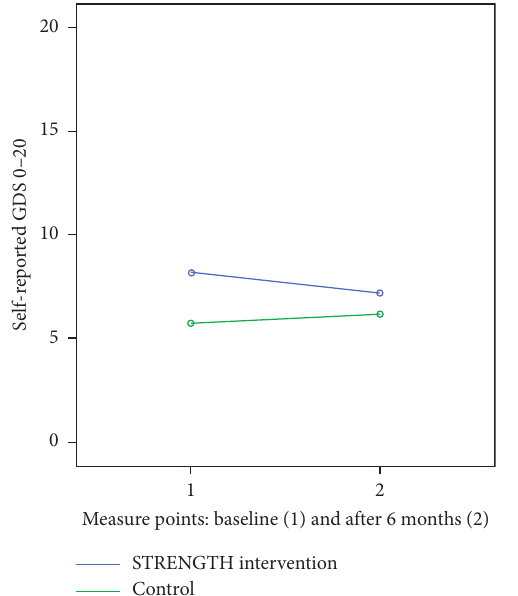
Figure 4: Reported level of sense of coherence (SOC-13) at baseline and after intervention: STRENGTH ( n � 18) versus control ( n �